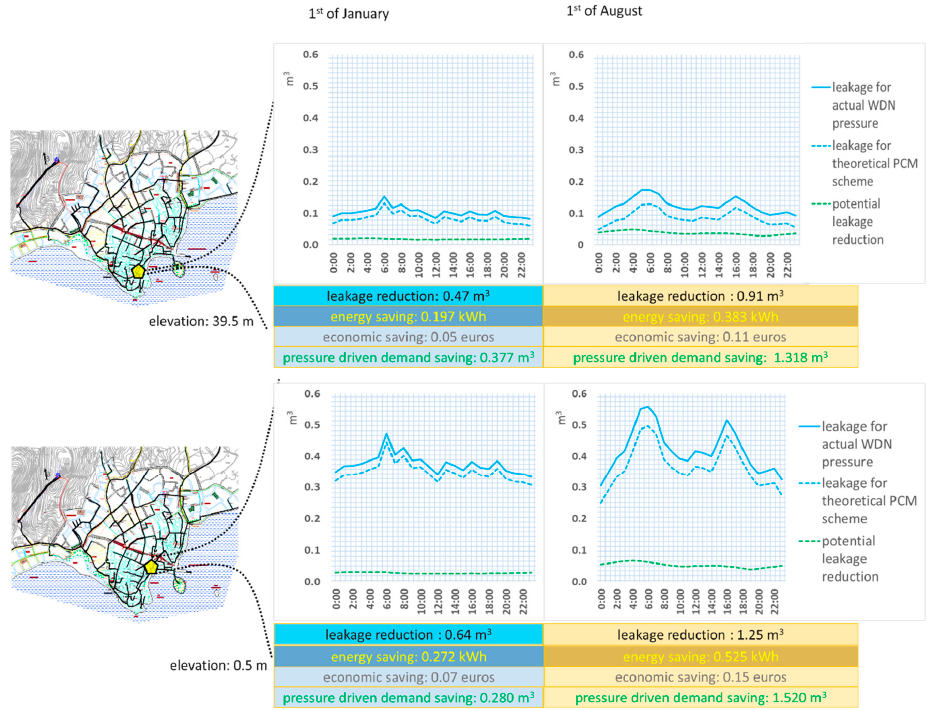
Figure 19. Beneficial effect of a theoretical PM scheme in two landzones of different elevation presented through different KPIs: hourly comparative curves of leakage for actual pressure scenario and PM scenario, the curve of the respective leakage reduction, daily values of leakage reduction, and daily values of savings in energy and euros, for 1 January and 1 August.